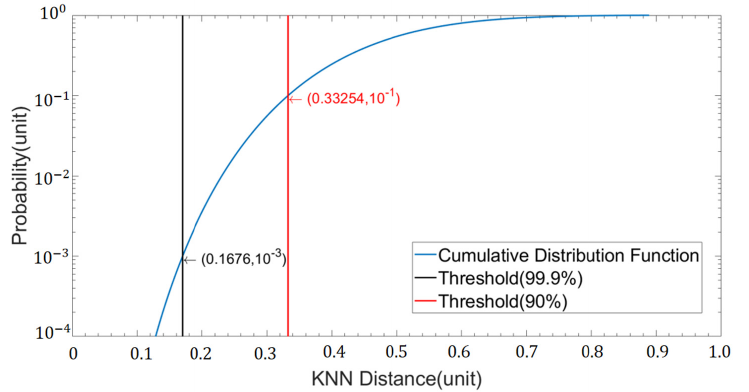
Figure 8. The cumulative probability distribution to determine the threshold position (background photon counts rate = 5MHz).